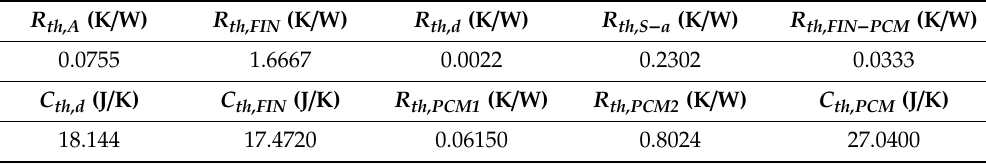
Table 3. The thermal network parameters of the heat sink.